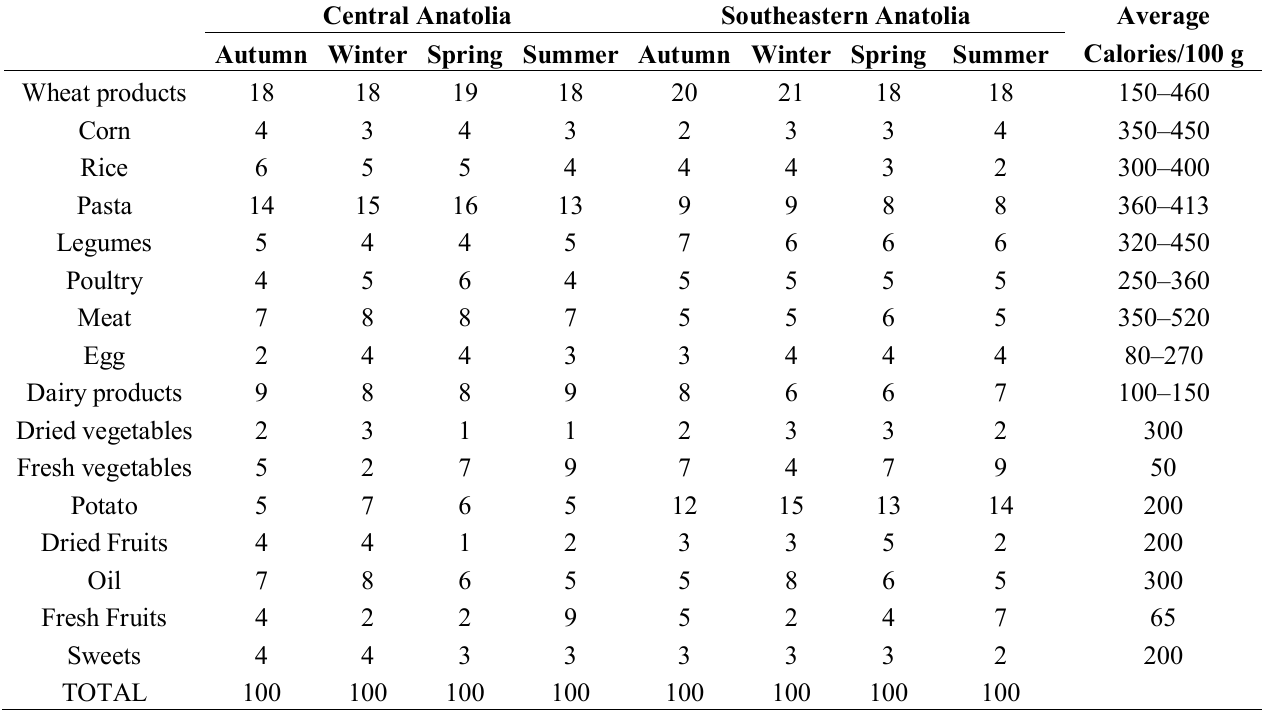
Table 3. The major foods consumed (%) in study area and their average calorie